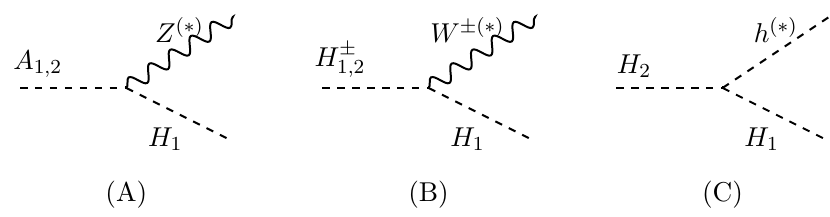
Figure 1 . Tree-level decays of heavy inert states into H 1 and on-shell or o(cid:11)-shell Z , W (cid:6) and h